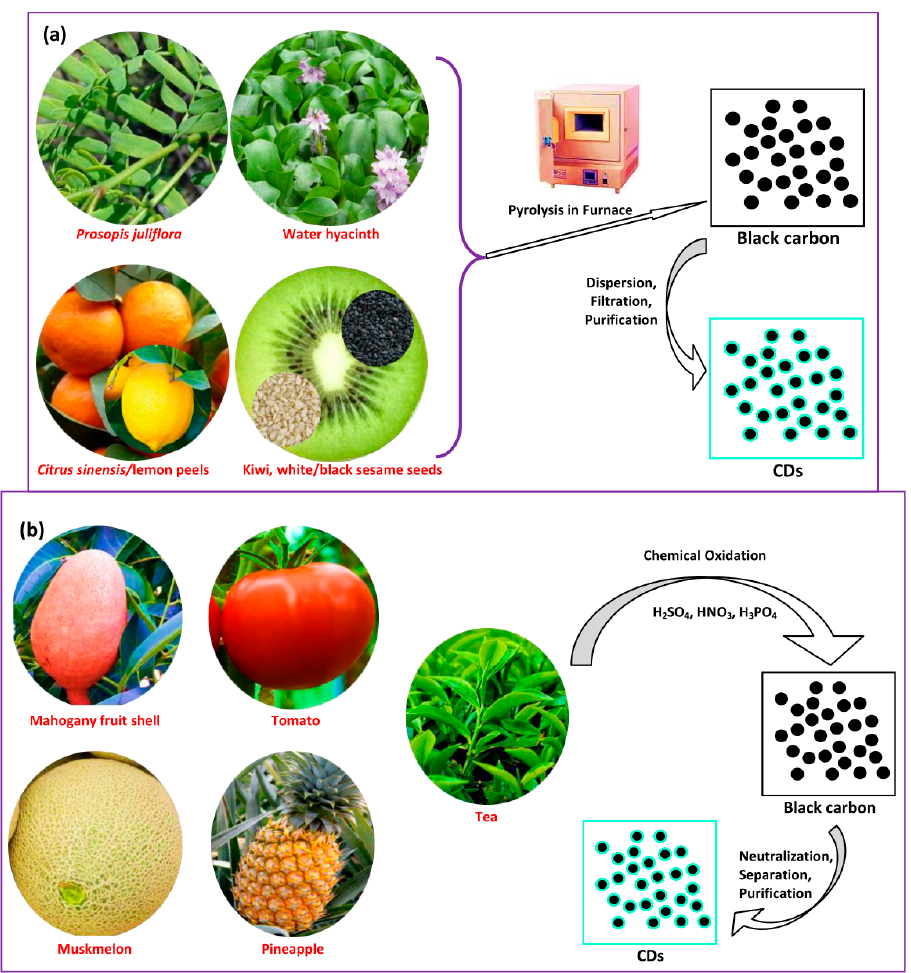
Figure 4. Illustration of the synthesis of plant part-derived CDs by ( a ) pyrolysis and ( b ) chemical oxidation methods.